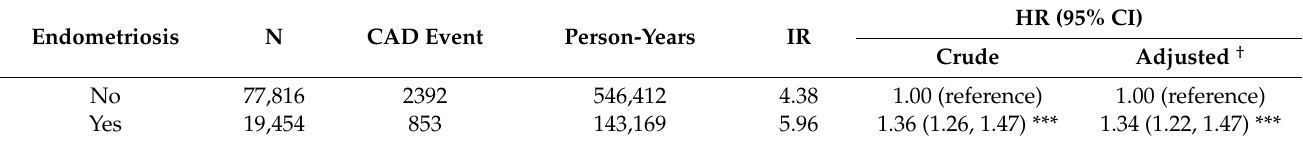
Table 2. Cox model-measured hazard ratios and 95% confidence intervals of CAD associated with gender, age, and comorbidity per 1000 person-years.